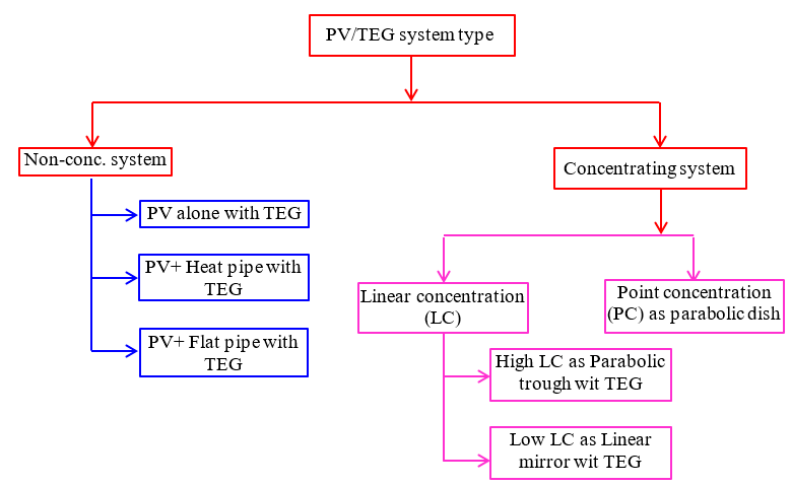
Figure 2. HPVTEG System Classifications.